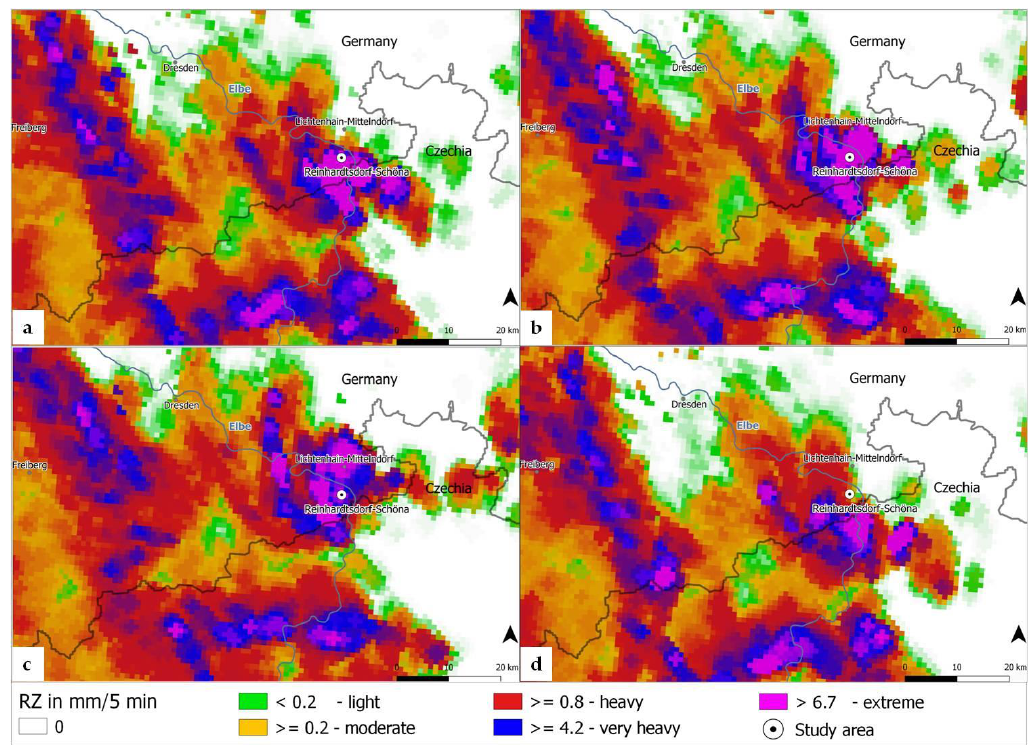
Figure 5. The selected storm event in 5-min time steps on 23 May 2016 from ( a ) 7:10 p.m., ( b ) 7:15 p.m., ( c ) 7:20 p.m. to ( d ) 7:25